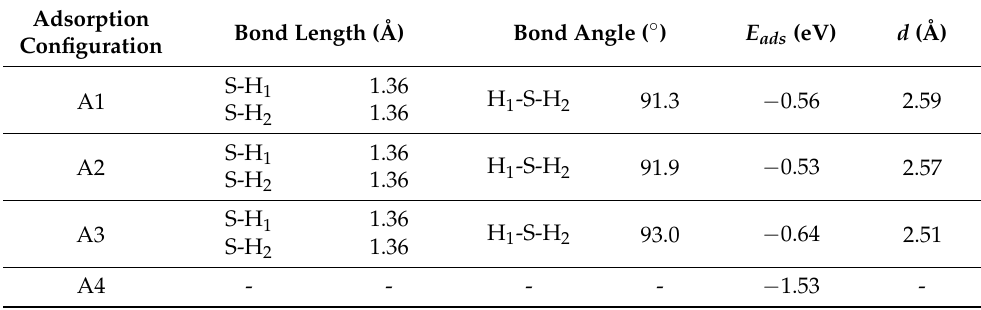
Figure 4. The stable adsorption configuration of H 2 S molecules on pure α -Fe 2 O 3 (001) surface ( A1 , A2 ); and the stable adsorption configuration of H 2 S molecules on vacancy α -Fe 2 O 3 (001) surface ( A3 , A4 ). The unit of number is Å. Table 1. The adsorption energy and characteristic parameters of adsorption configuration of H 2 S on the α -Fe 2 O 3 (001)